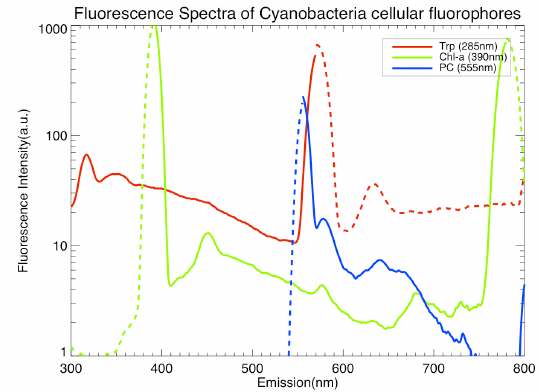
Figure 2. Fluorescence emission curves of three cyanobacteria cellular